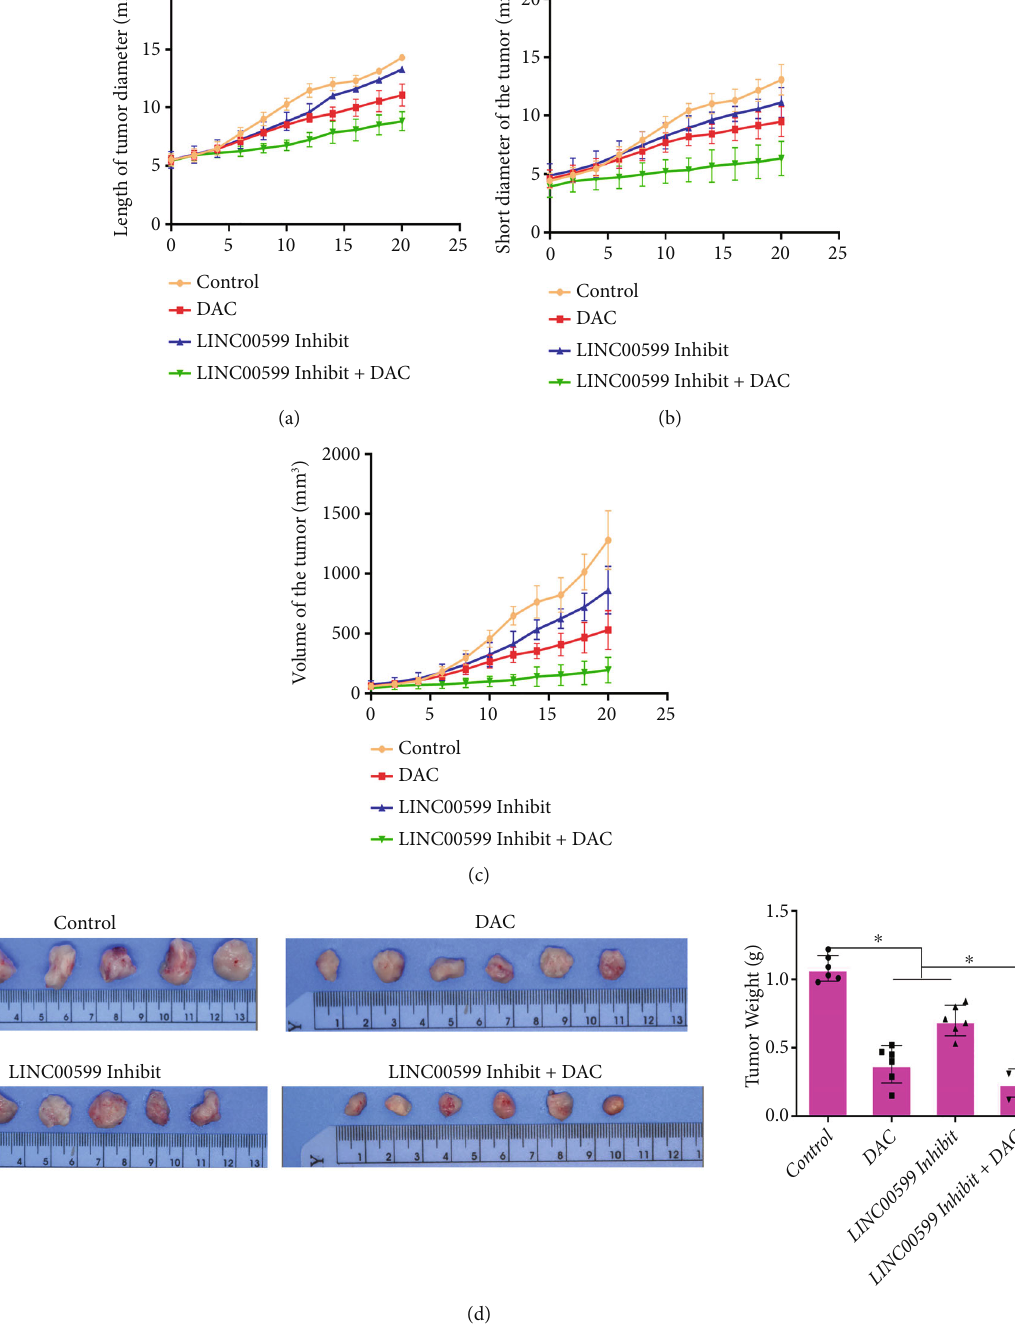
Figure 6: DAC a ff ecting tumor proliferation in nude mice via LINC00599. Calculation of the tumor (a) long diameter, (b) short diameter, (c) volume, and (d)